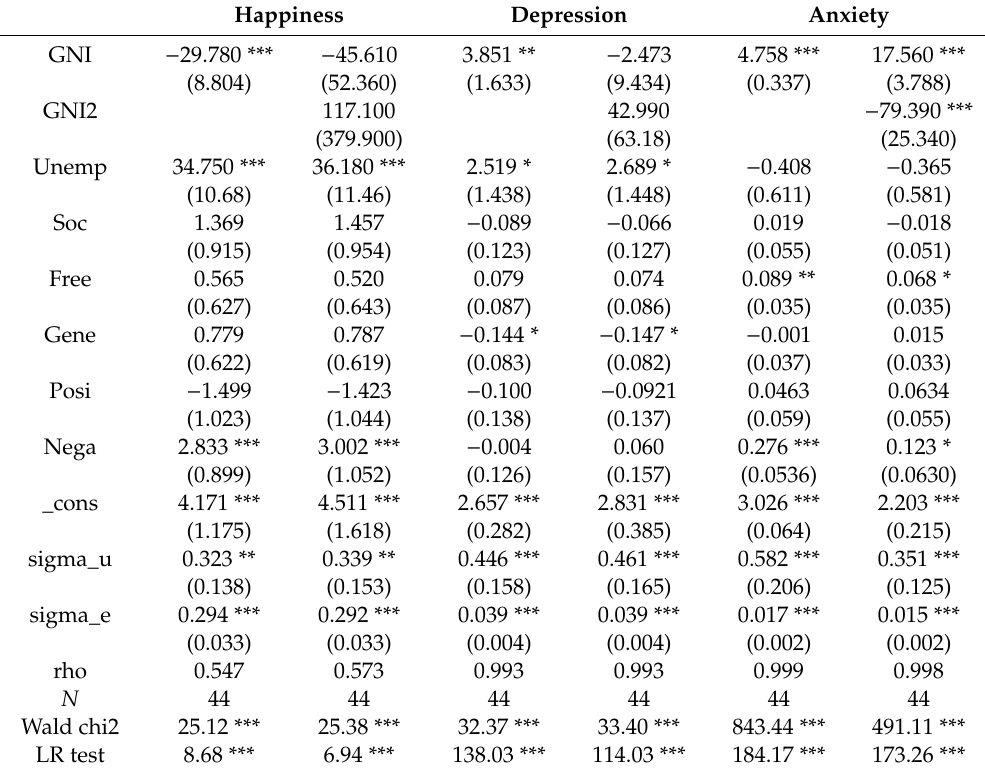
Table 7. The impact of national income on mental health among low-income